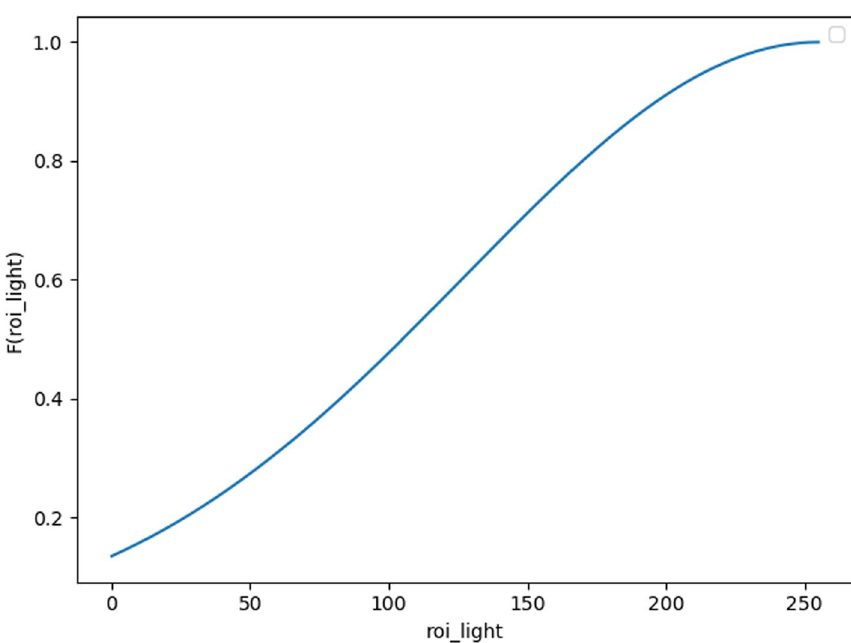
Fig. 5 The light sensing adaptive suppression function